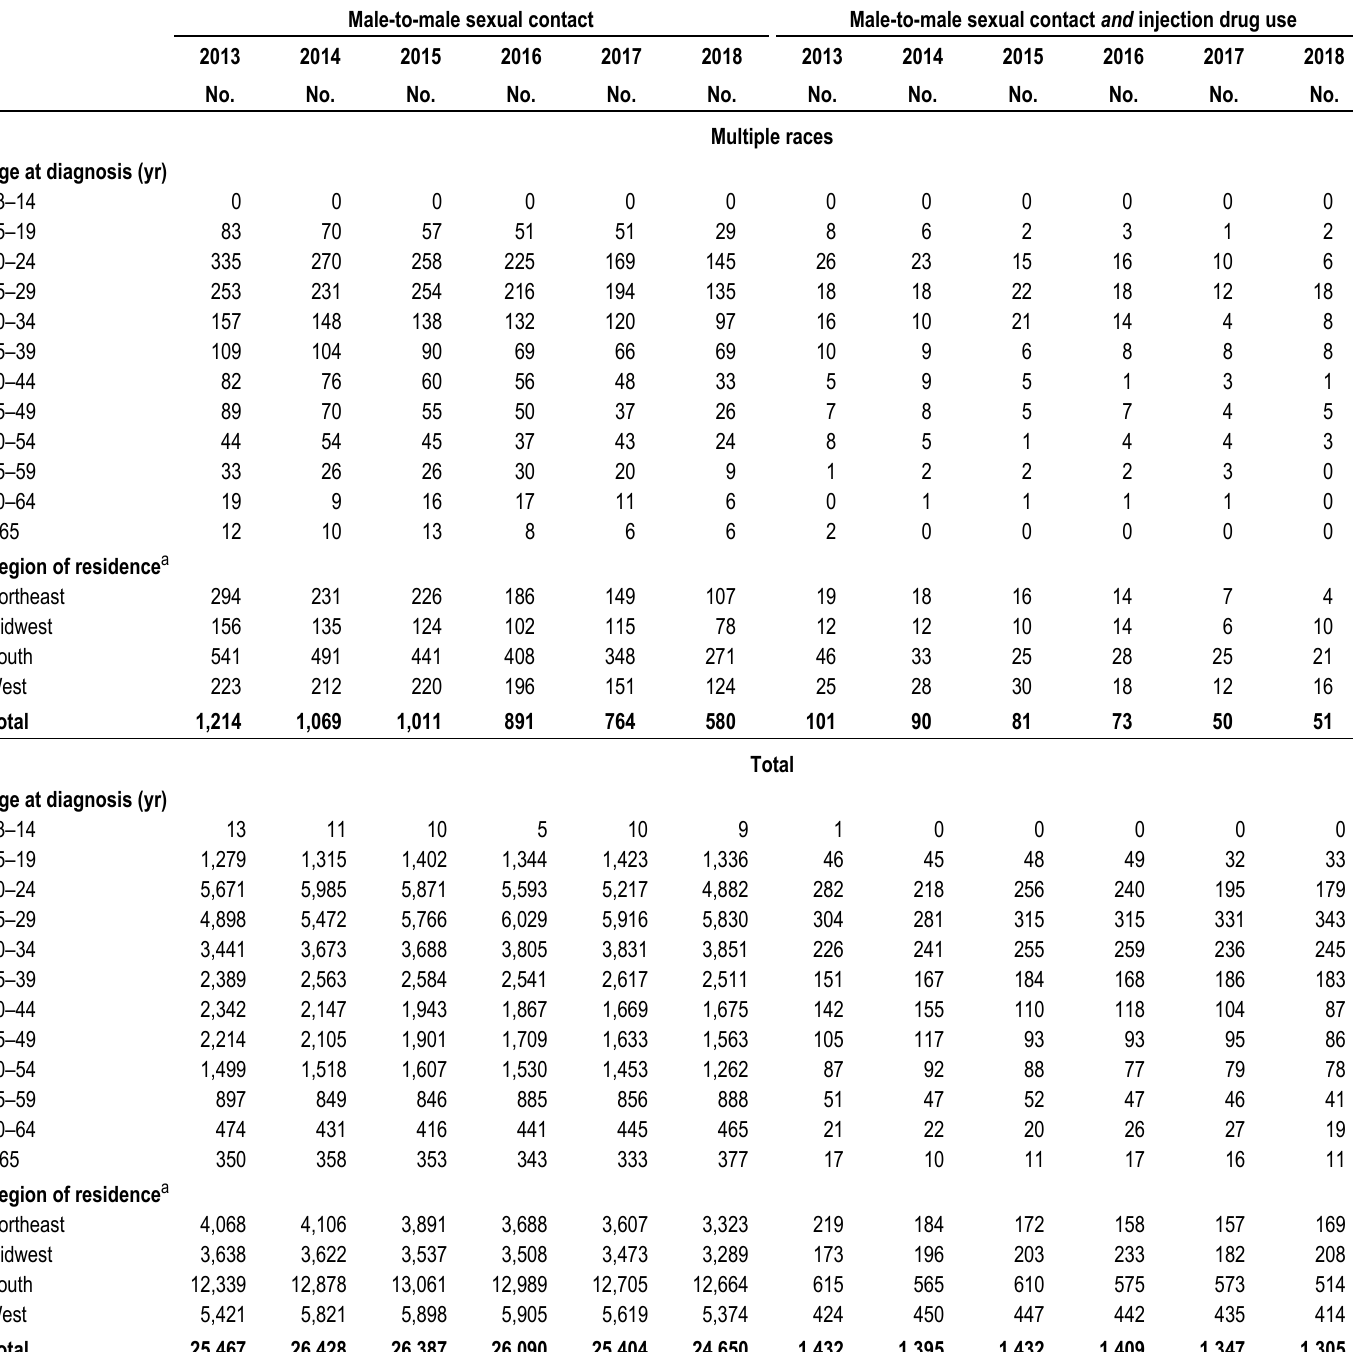
Table 7a.Diagnoses of HIV infection attributed to male-to-male sexual contact and male-to-male sexual contact and injection drug use, by selected characteristics, 2013–2018—United States (cont) Male-to-male sexual contact Male-to-male sexual contact and injection drug